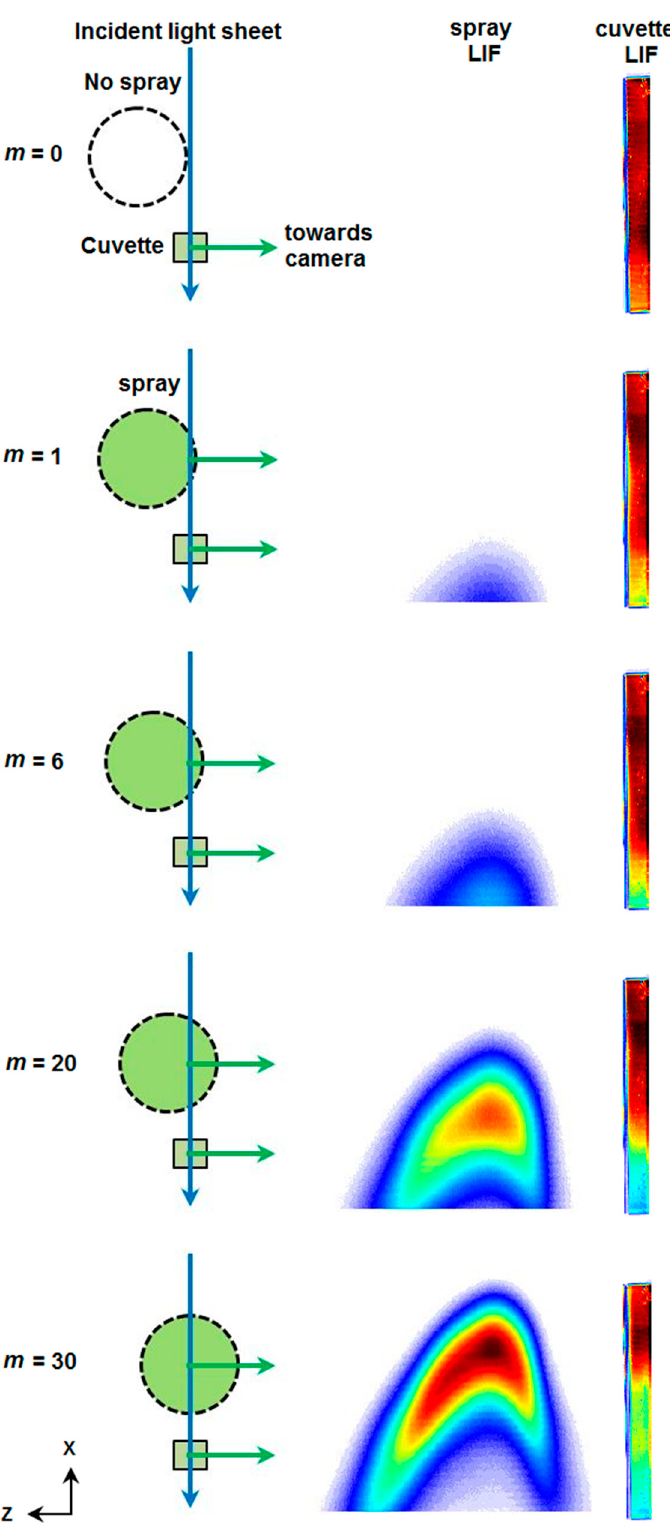
Figure 6. Illustration of the SLIPI-scan technique in top view ( left column ), SLIPI-LIF image of the spray ( middle column ), and corresponding light transmission images of the reference cuvette ( right column ). Each row depicts a different plane m of the SLIPI-scan.